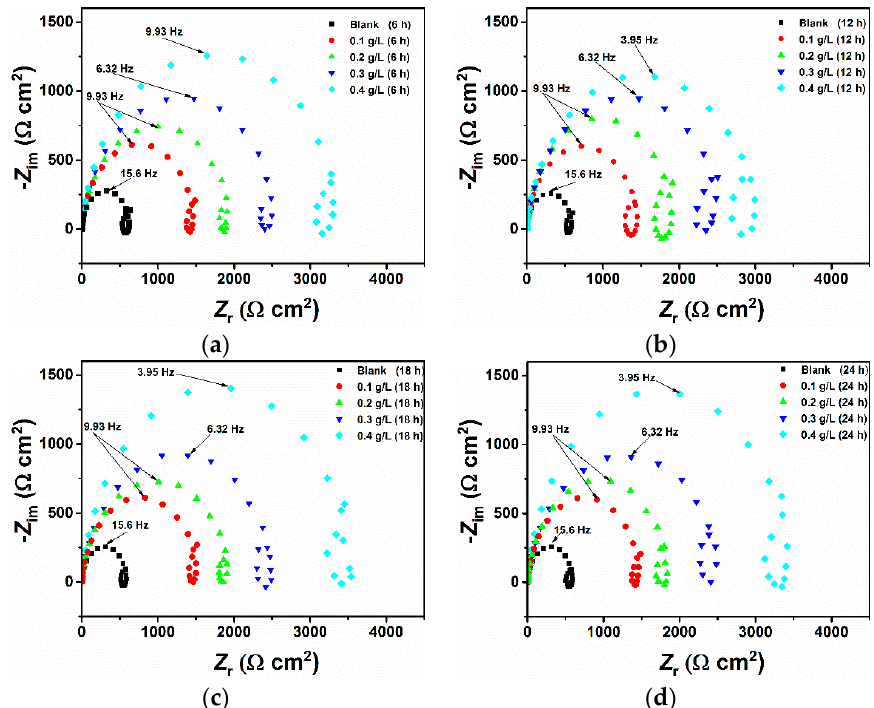
Figure 4. Nyquist plots recorded at open circuit potentials for pure aluminium in 1-M HCl without and with the addition of different concentrations of GG at 25 °C after 6 (a) , 12 (b) , 18 (c) , and 24 (d) h of immersion in the absence and presence of different concentrations of the GG.